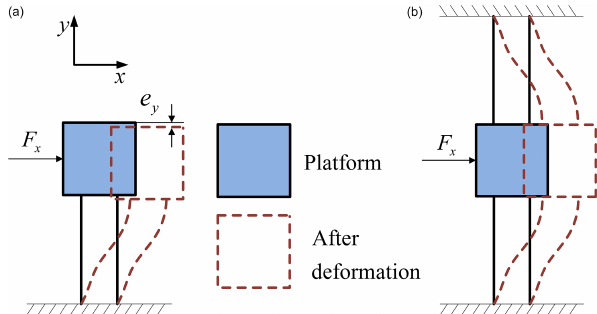
Figure 2. Parallelogram joints for planar parallel mechanisms: (a) one parallelogram joint; (b) two parallelogram joints with sym- metric